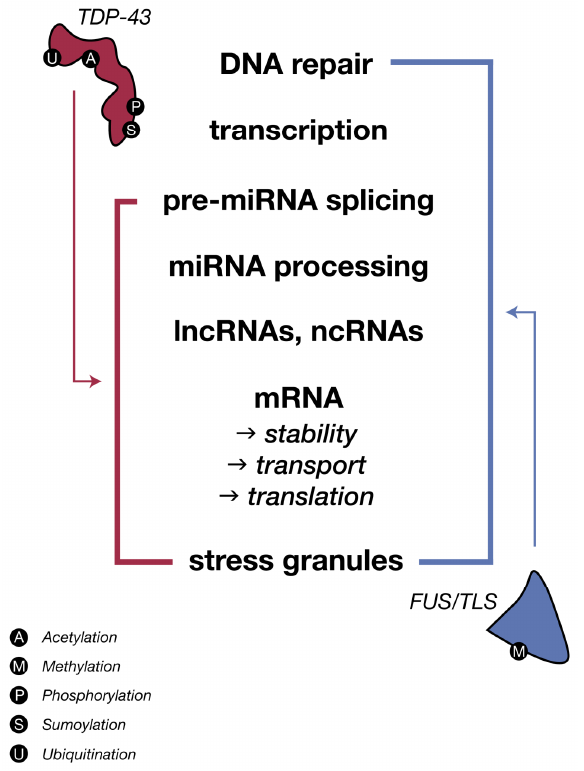
Figure 3. The two major ALS RNA-binding proteins, TDP-43 and FUS / TLS, share regulation of all aspects of RNA (metabolism, biogenesis and life cycle), despite variations in their biochemical processes. Schematic diagram depicts the sharing and distribution of molecular functional between these two major proteins. Figure 3: Idea adapted from Therrien M and Parker AJ. Worming forward: ALS toxicity mechanisms and genetic interactions in C. elegans . Frontiers in Genetics. 2014. https//doi.org/103389/fgene:2014-0085.